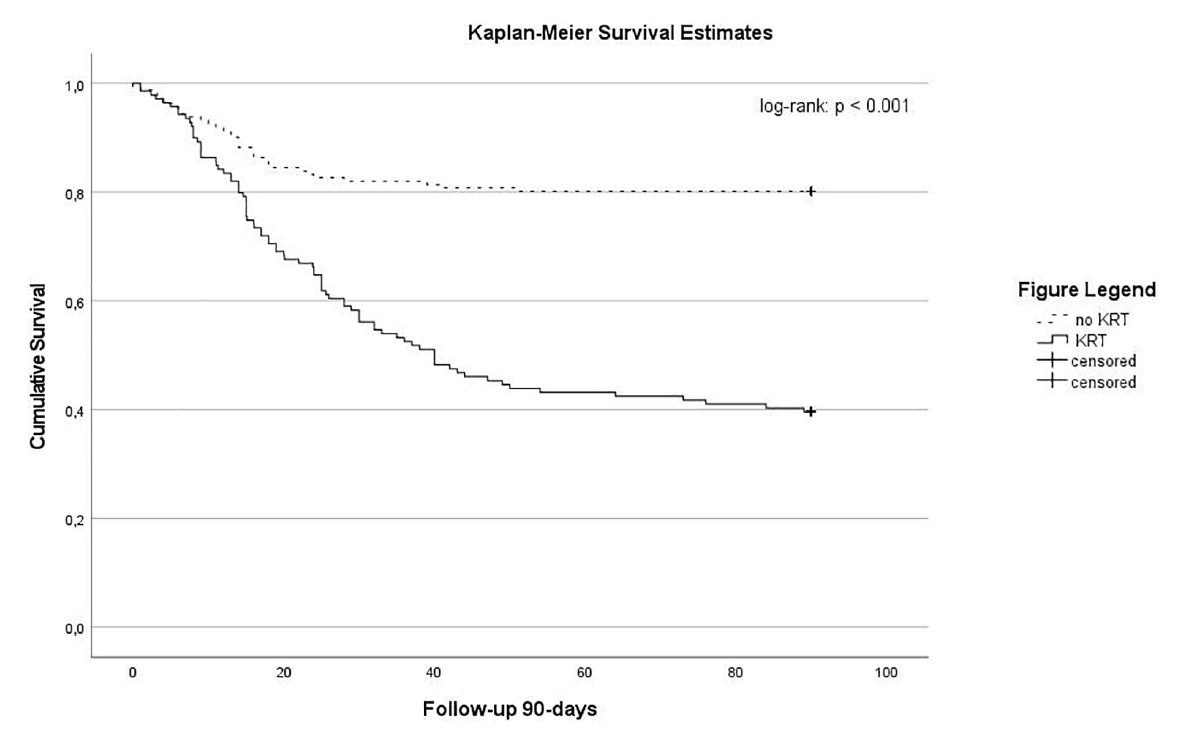
FIGURE2 Kaplan-Meier survival estimates stratified according by the use of renal replacement therapy (log-Rank: p <